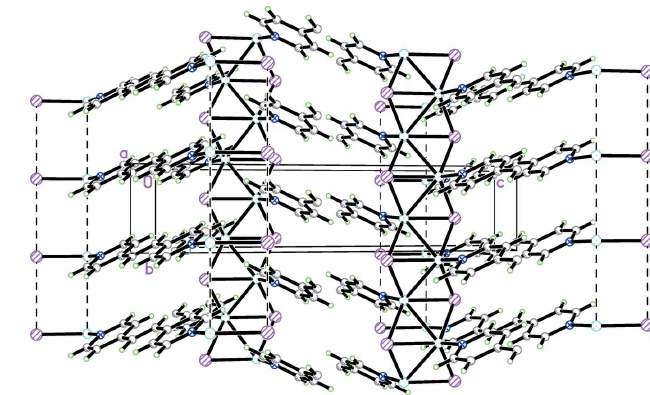
Figure 3 Fragment of the crystal packing along the a -axis direction. Dashed lines indicate intermolecular Cu (cid:3)(cid:3)(cid:3) Cu and I (cid:3)(cid:3)(cid:3) I contacts.